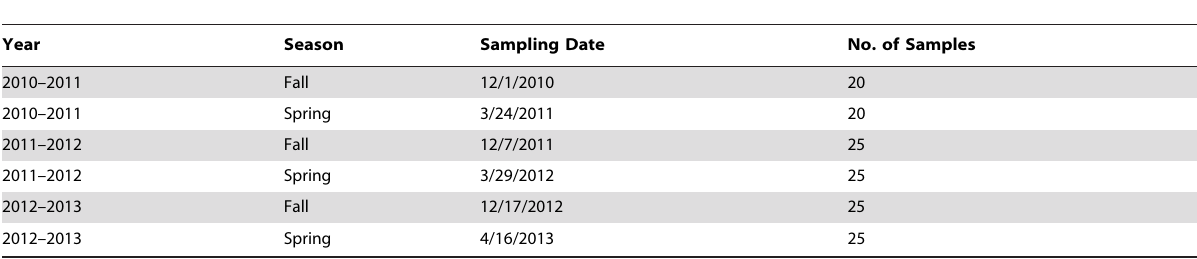
Table 1. Sampling dates for S. homoeocarpa overwintering sample collections.